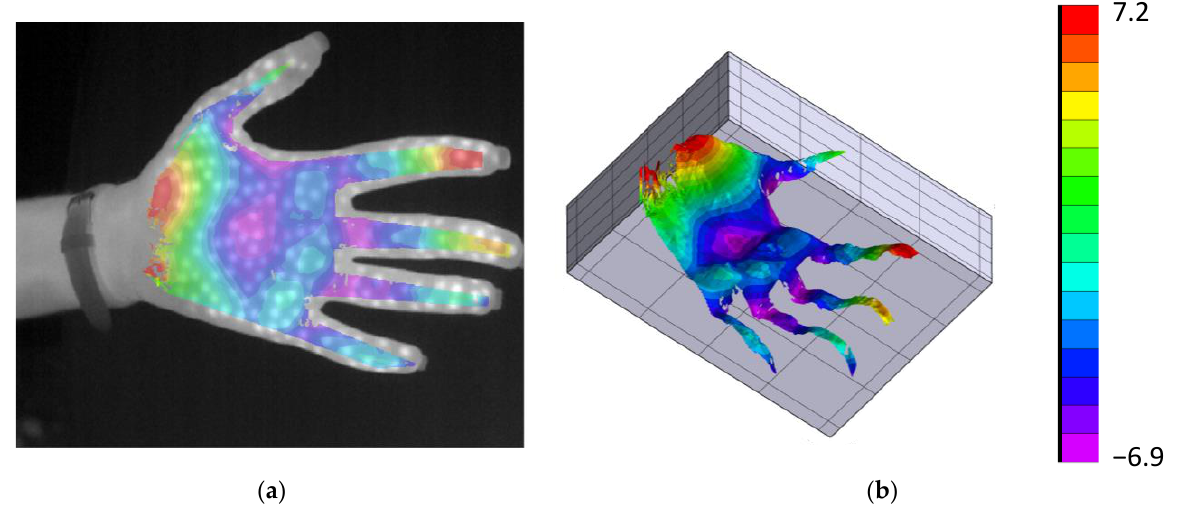
Figure 8. Results for digitalization a human hand. ( a ) Shape-map on image. ( b ) 3D map of the shape .